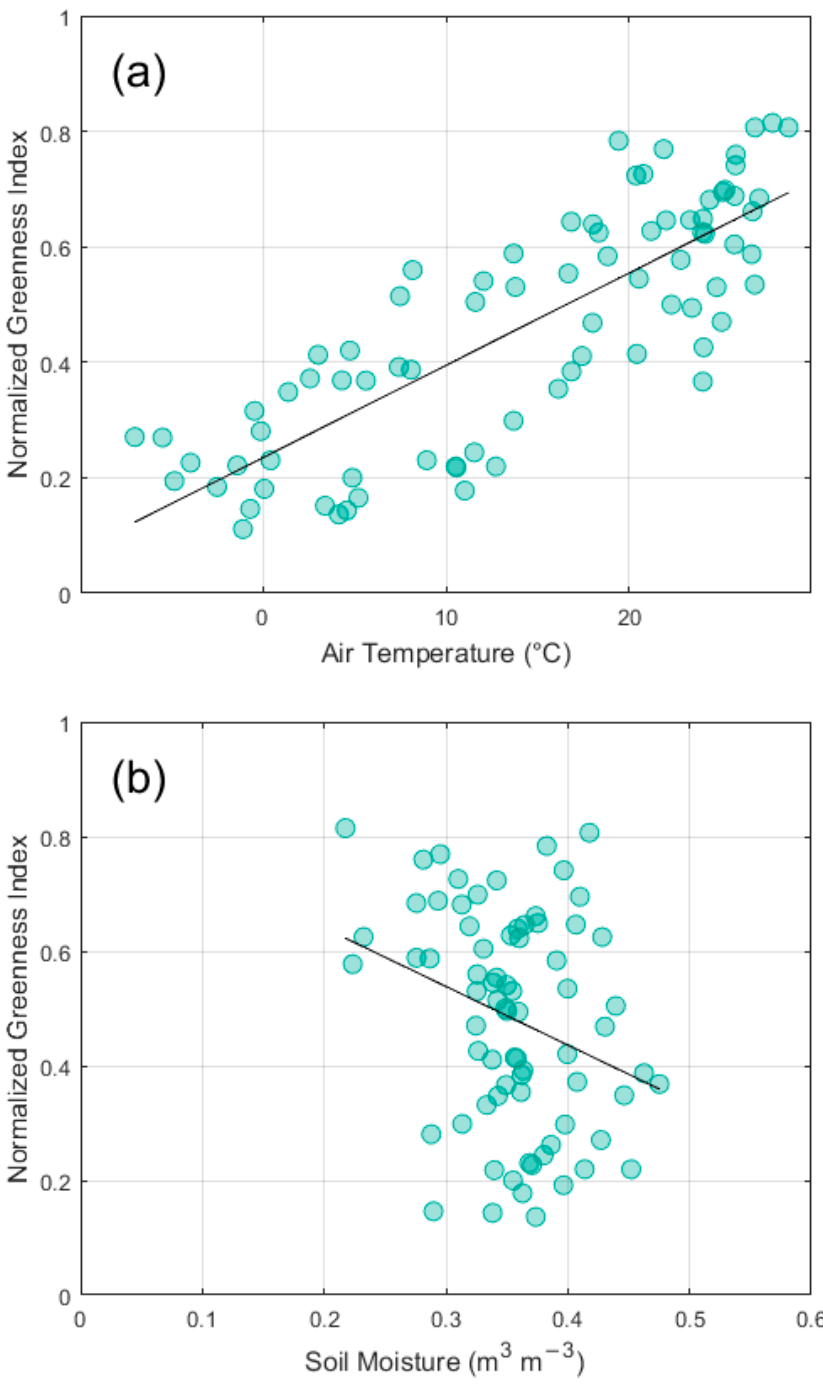
Figure 7. Relationships of the normalized greenness index with ( a ) air temperature and ( b ) soil moisture. Black lines indicate linear regression lines.